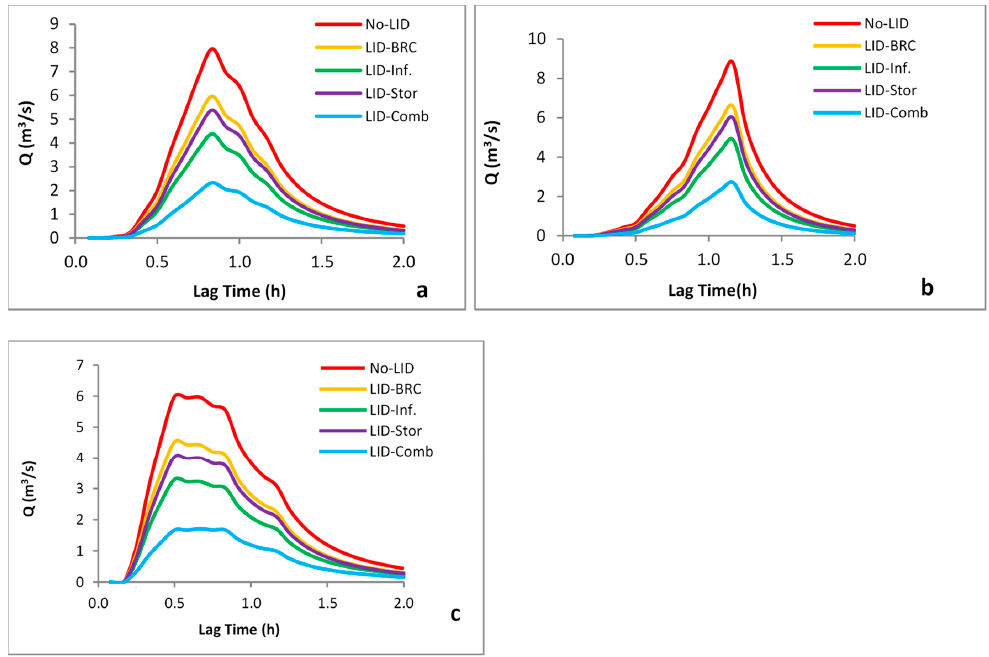
Figure 8. Impact of LID Scenarios on 1 h duration rainfall patterns: ( a ) TS1 (r = 0.4–0.6); ( b ) TS2 (r = 0.8–1) and ( c ) TS3 (r = 0–0.2).